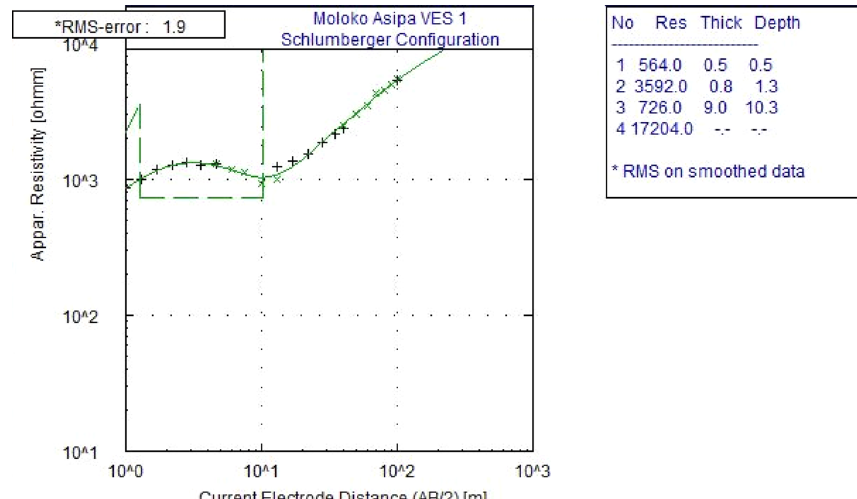
Fig. 10 Fraser and Karous– Hjelt representation for traverse